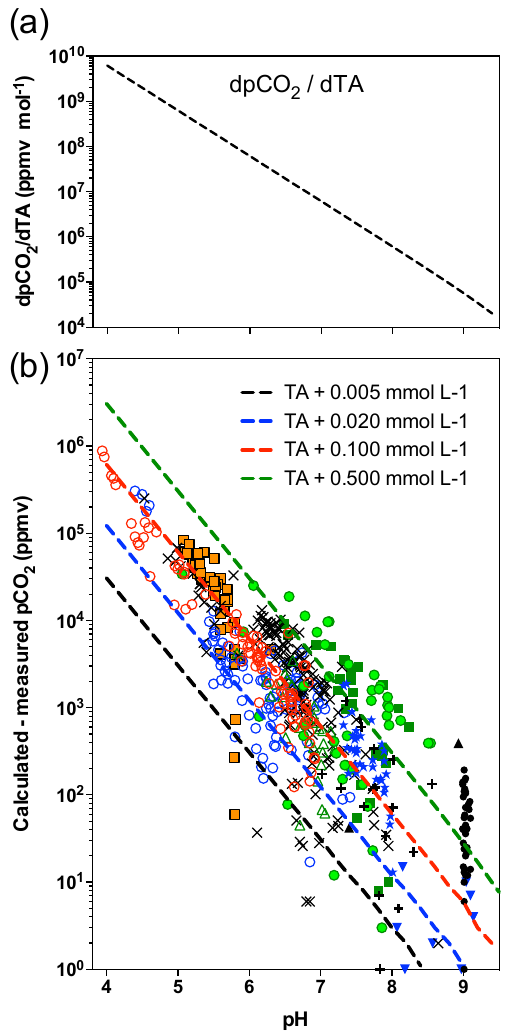
Figure 6. Sensitivity of p CO 2 overestimation to pH: (a) theoretical factor d p CO 2 / dTA, which describes the sensitivity of calculated p CO 2 to the TA value; (b) the solid lines show the increase in cal- culated p CO 2 induced by various increases in TA, as functions of pH; these lines mimic the overestimation of calculated p CO 2 gen- erated by increasing contributions of organic alkalinity to the TA; field data (as calculated – measured p CO 2 ) have been plotted for comparison; same symbols as in Fig. 3. Note that negative values do not appear in the logarithmic